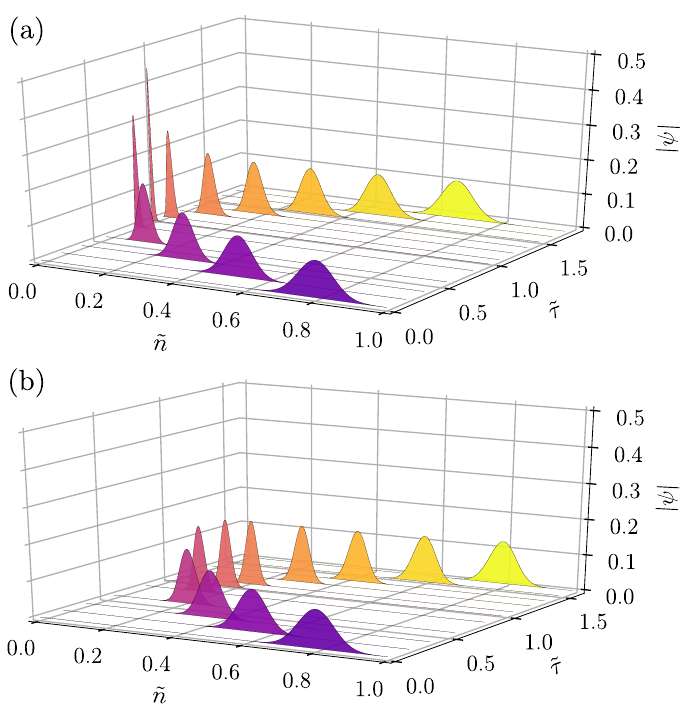
Figure 2: Time evolution of a Gaussian wave packet in the lattice model, with γ = 1 / 2, ˜ n = 0.8, and ˜ w = 0.05 for a lattice of size N = 1001. The initial mo- 0 = − π/ 2 (top) and p = − 0.7 × π/ 2 (bottom). In both cases, the wave menta are p 0 0 packet is reflected, but it only reaches the origin of the lattice in the first